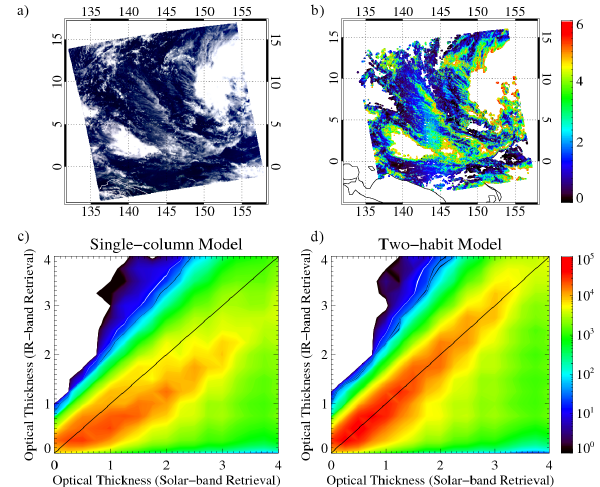
Figure 12. (a) RGB image of an Aqua/MODIS granule from 24 February 2014 at 03:50UTC. (b) Retrieved optical thickness of thin ice clouds. (c) and (d) are comparisons of ice cloud optical thick- nesses retrieved from the MODIS solar bands and IR bands, and the results are based on the single-column model and two-habit model, respectively. The histograms illustrate occurrences of thin ice cloud pixels, and the red color corresponds to the high frequency of oc-